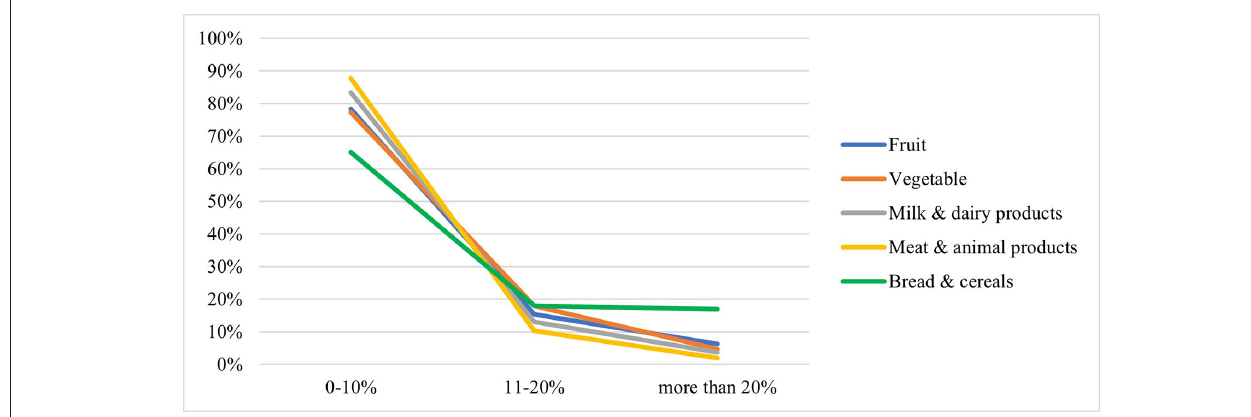
FIGURE 3 | Household food waste. Source: own processing and data collection.